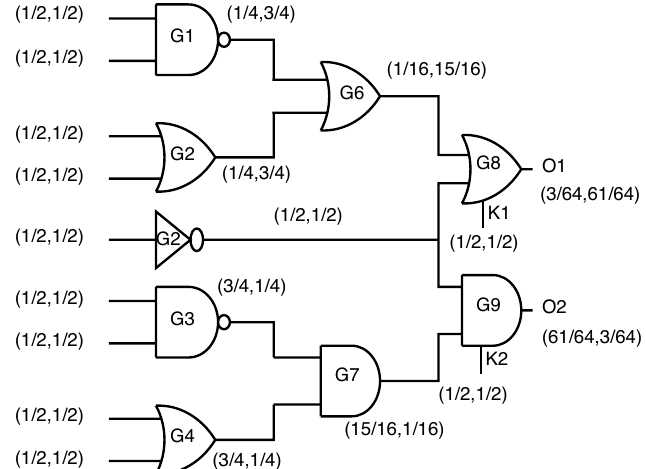
Figure 27. Case-2: Probability analysis using proposed gates.